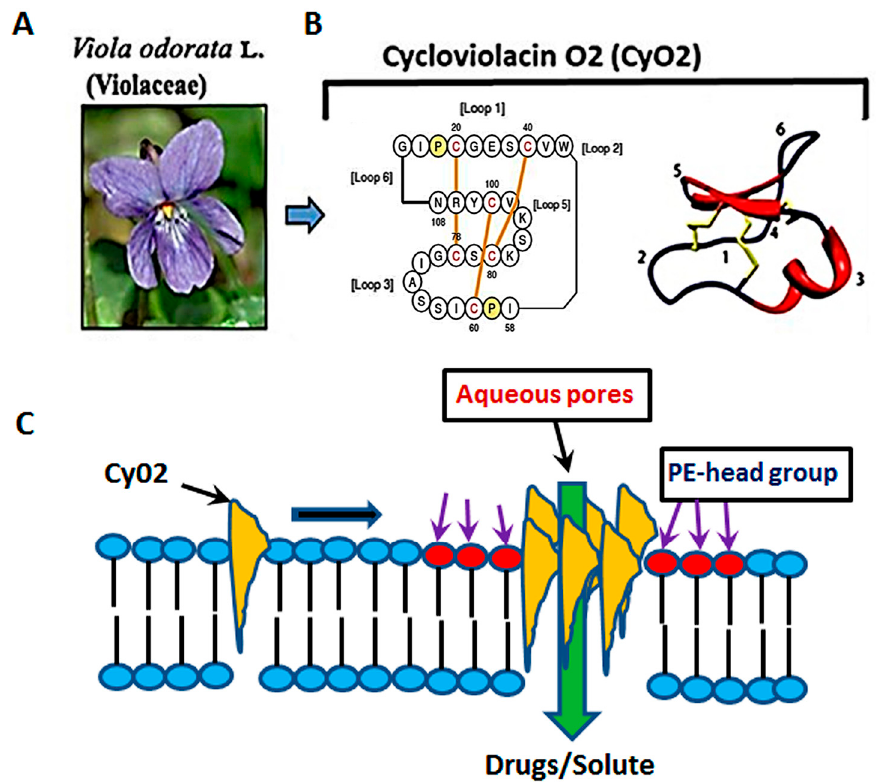
Figure 1. The membrane-active properties of CyO2. ( A ) CyO2 was isolated and purified from the leaves of Viola odorata L. (Violaceae). ( B ) Amino acid sequence and the 3-D structure of this cyclic peptide are shown. ( C ) A schematic of the membrane targeting, multimerization and pore-formation ability of cyclotides. CyO2 has an affinity for ‘raft-like’ membrane microdomains that are rich in phosphatidyl ethanolamine (PE).